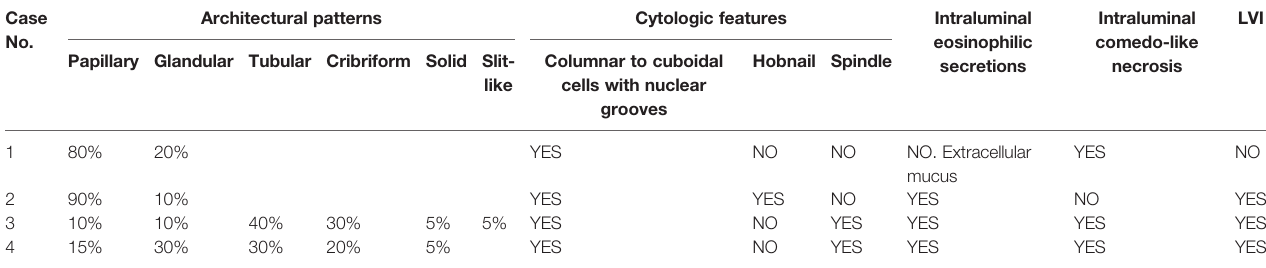
TABLE 2 | Histomorphological characteristics of uterine corpus mesonephric-like adenocarcinomas. Case